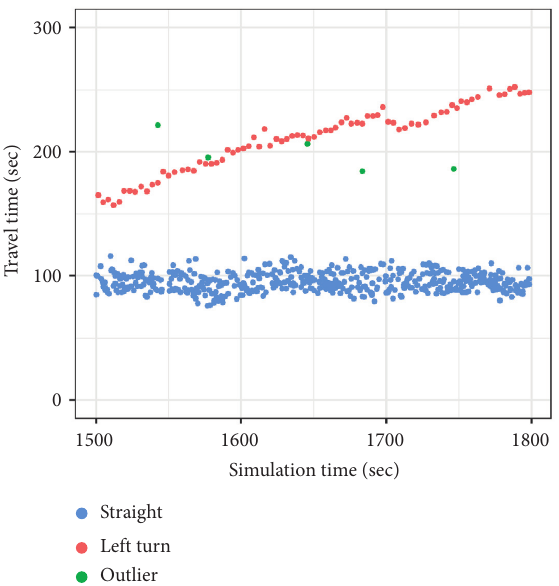
Figure 2: Travel time data of different traffic streams at the upstream of diverge bottleneck.